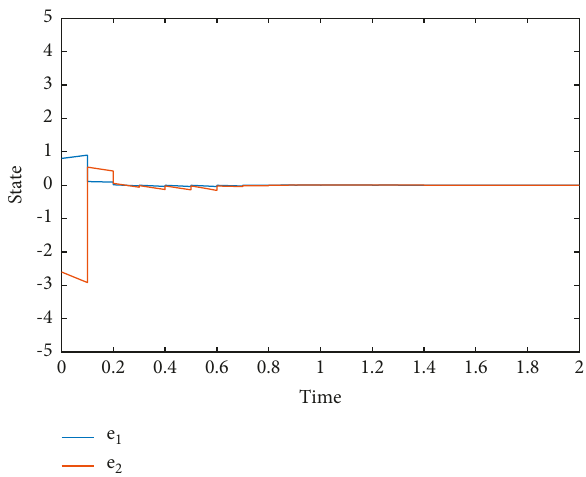
Figure 1: The trajectory of an error NN (12) with control inputs.